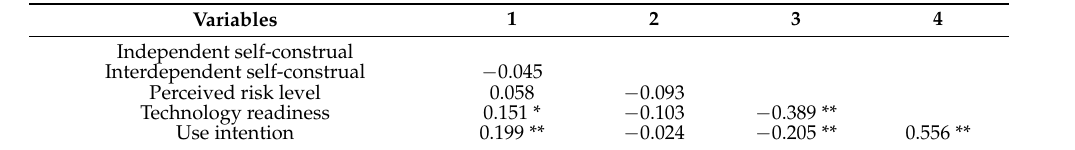
Table 3. Correlations.